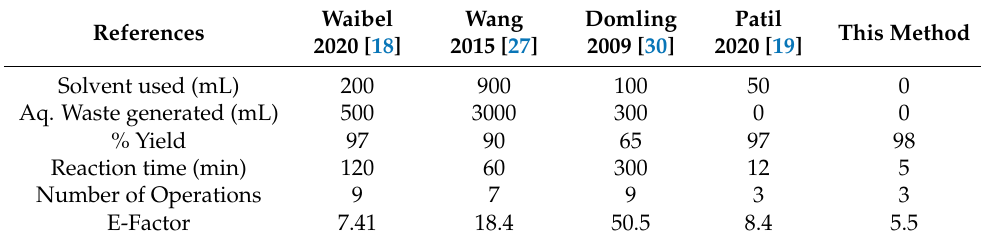
Table 5. Comparison of various parameters for 100 mmol synthesis of various optimized